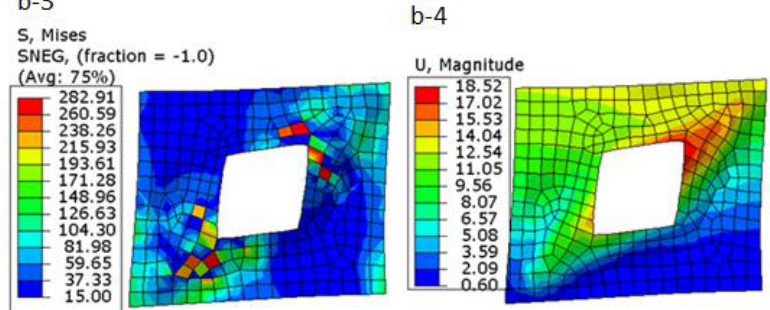
Figure 11. Von Mises stress and displacement for concrete part (b-3) stress and (b-4) displacement.